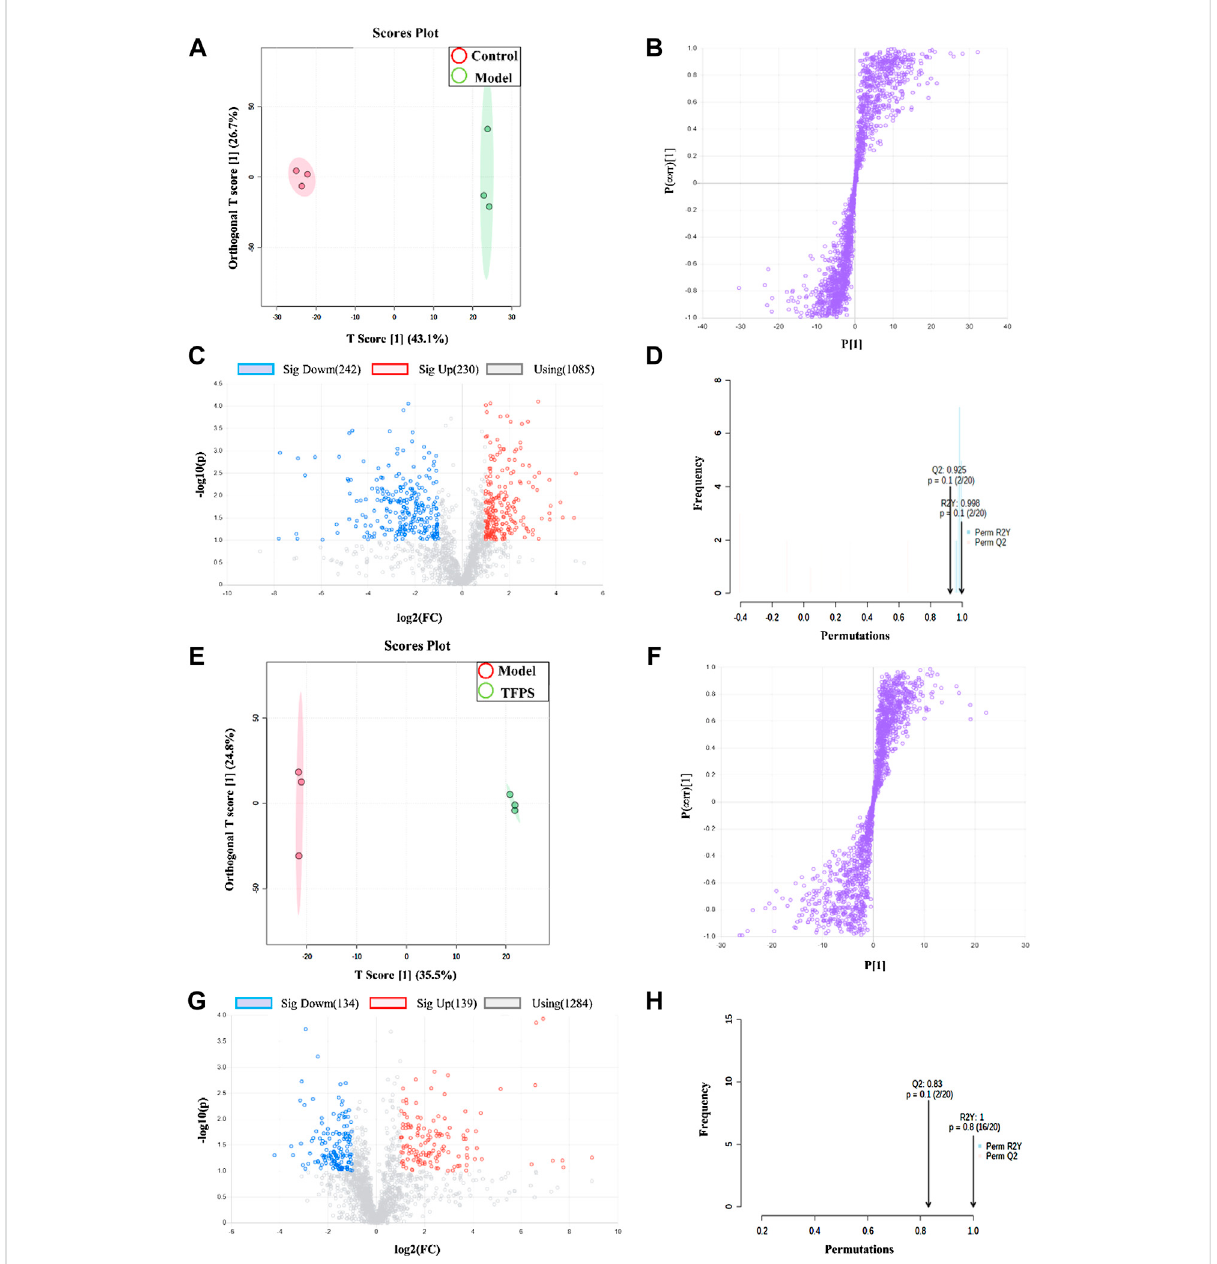
FIGURE 9 OPLS-DA analysis on experimental groups. (A) OPLS-DA score chart for control and model groups. (B) Statistically veri fi ed scatter plot was obtained through 2000X replacement test for control and model groups. (C) OPLS-DA S-plot of metabolic pro fi ling for control and model groups. (D) Volcano chart bytheOPLS-DAanalysisforcontroland modelgroups. (E) OPLS-DAscore plotfor modeland TFPSgroups. (F) Statisticallyveri fi ed scatterplotwasobtainedby2000XpermutationtestformodelandTFPSgroups. (G) OPLS-DAS-plotofmetabolicpro fi lingformodelandTFPS groups. (H) Volcano plot for model and TFPS